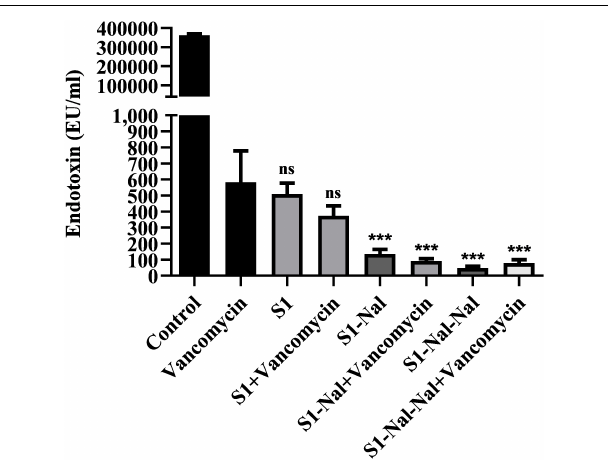
FIGURE 5 | Attenuation of LPS release from E. coli . Escherichia coli BCRC 13B0198 were incubated at the mid-log phase (10 4 CFU/ml) and treated with peptide alone (at 1 × MIC) or combination with vancomycin (both at 0.5 × MIC) at 37 ◦ C for 6 h. The samples were filtered through 0.2 µ m pore filter and the endotoxin level was detected by LAL assay. *** P < 0.001 compared with vancomycin only. ns, no significant differences compared with vancomycin only.